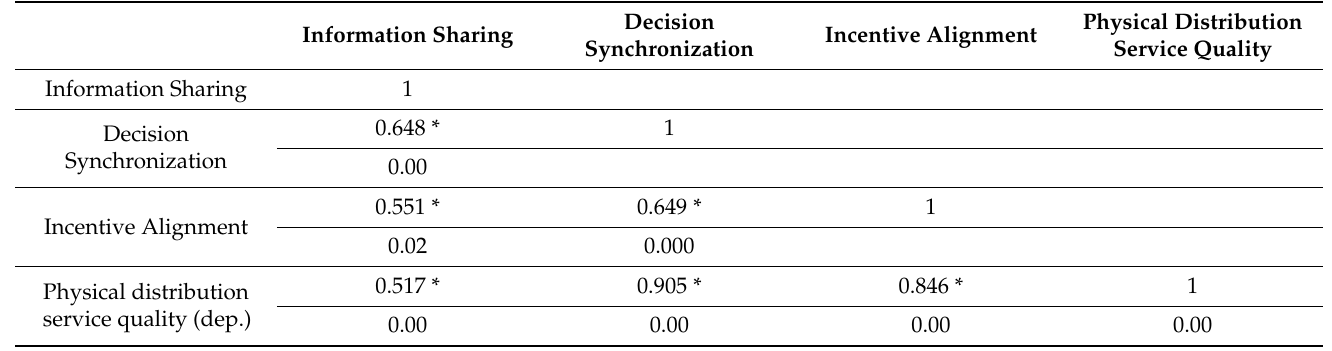
Table 3. Cross-tabulationofaspectsofcollaborativecommunicationandindependentphysicaldistribution.